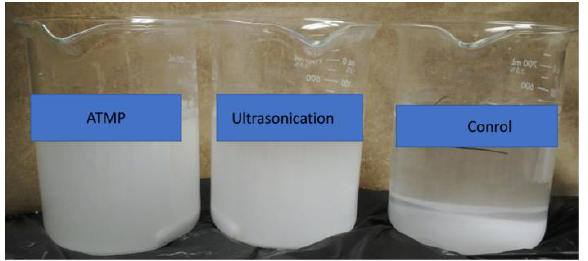
Figure 9. Photographs of ultrasonication treatment with ATMP and control after 60 min.